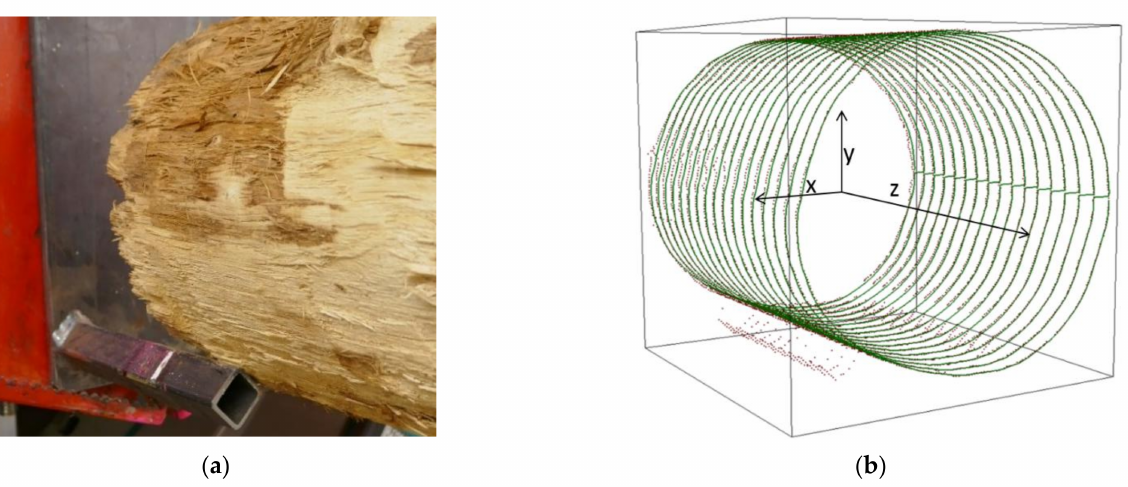
Figure 3. Log on the supports during the measurement ( a ) and the filtering process ( b ) of the data in the last eight centimeters of the log (original data in brown, filtered data in